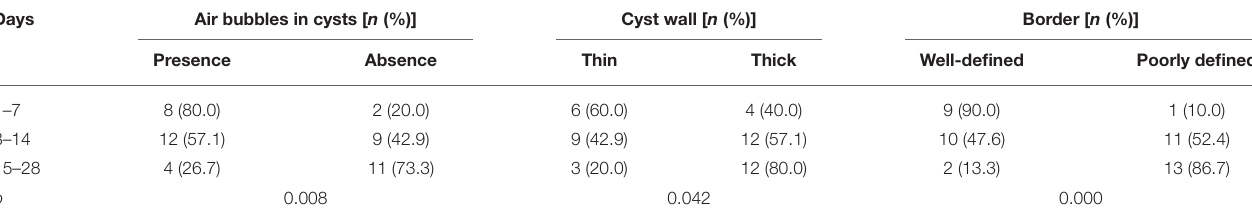
TABLE 3 | The analysis of air-containing, the cyst wall, and border of CPSF in newborns of different